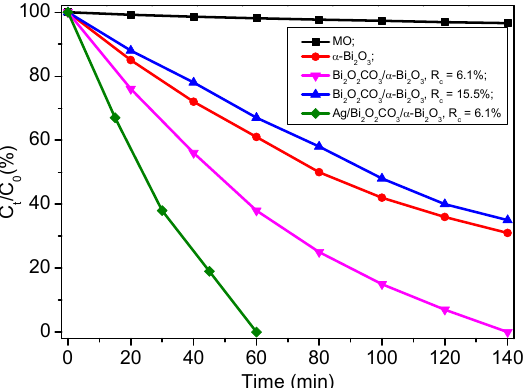
Figure 10. The residual MO at different irradiation time for the as-prepared samples. Photogenerated electrons, holes, ·O 2− , and ·OH are considered to be major reactive species in organics photodegradation [32]. MO can be degraded into CO 2 , H 2 O, and other products by those reactive species [33]. In order to clarify the reaction mechanism further, 1 mmol of various scavengers was introduced to explore the specific reactive species that might play important roles in MO degradation by Ag/Bi 2 O 2 CO 3 /α-Bi 2 O 3 . Benzoquinone (BQ), ethylene diaminetetraacetic acid (EDTA), and tertiary butanol (TBA) were used as the scavengers for ·O 2− , holes, and ·OH, respectively [34]. Figure 11 shows the photodeg- radation efficiencies of MO by Ag/Bi 2 O 2 CO 3 /α-Bi 2 O 3 in the presence of these scavengers under visible light irradiation for 60 min. Both BQ and TBA show suppression of the deg- radation rate of MO, with TBA exhibiting a stronger suppressing effect. Meanwhile, EDTA shows a much weaker suppressing effect than BQ and TBA, suggesting that ·OH and ·O 2− are the major reactive species responsible for the photodegradation of MO by Ag/Bi 2 O 2 CO 3 /α-Bi 2 O 3 .